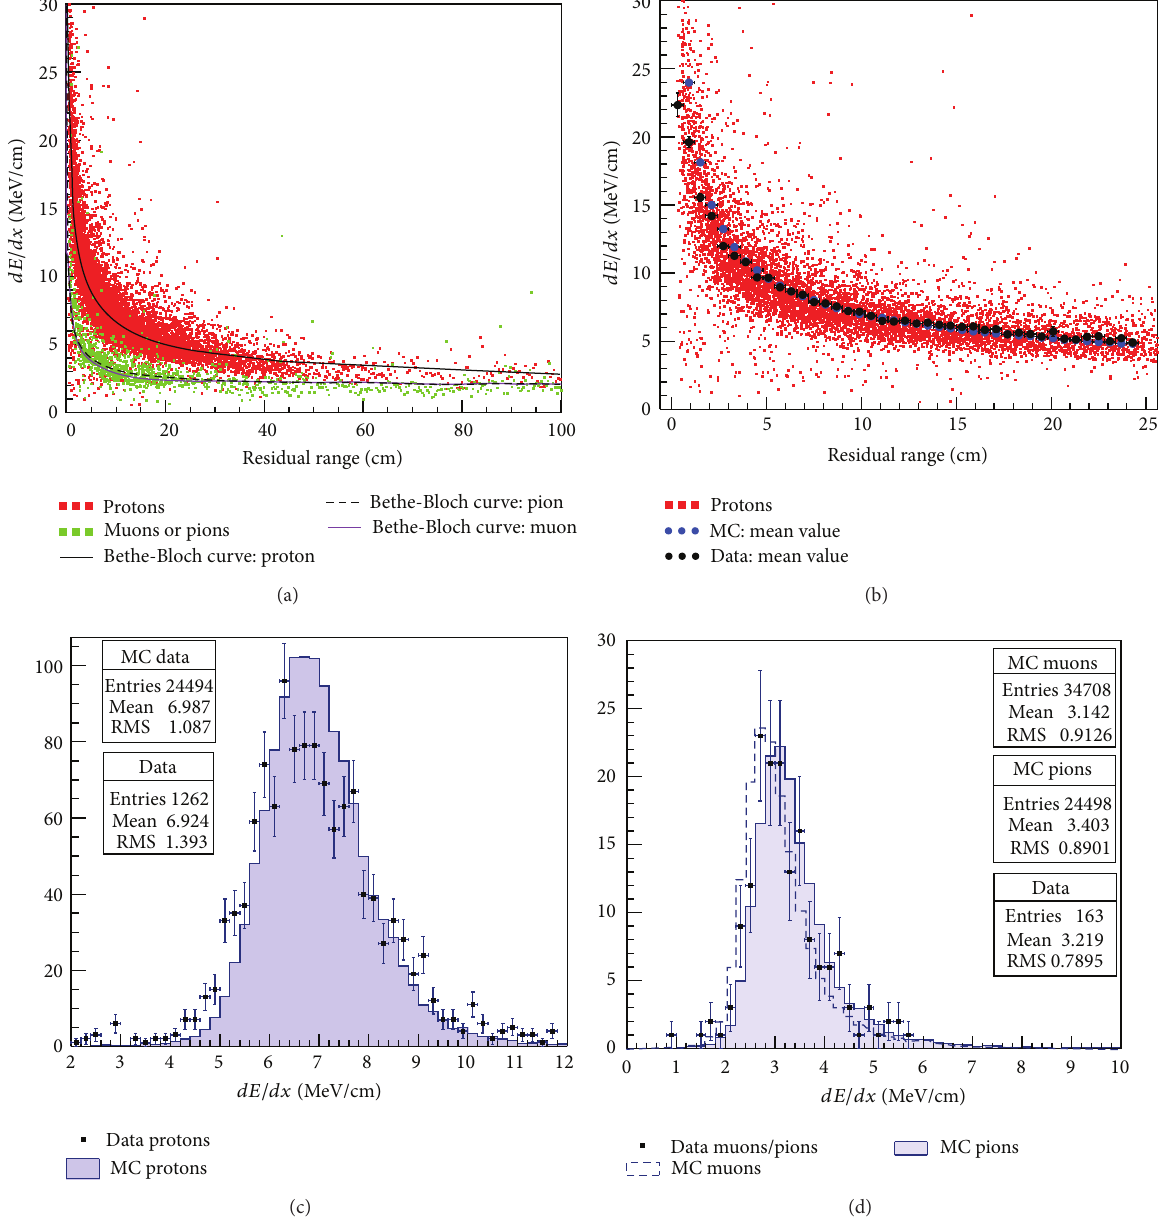
Figure 13: (a) The selected sample of data tracks identified as proton or 𝜇 / 𝜋 tracks; (b) mean value of 𝑑𝐸/𝑑𝑥 distributions in 6mm bins of residual range: black-data tracks identified as protons; blue-simulated proton tracks; points in the background-data tracks identified as protons; (c) 𝑑𝐸/𝑑𝑥 in 8–12cm residual range for tracks identified as protons, compared to simulated proton tracks; (d) 𝑑𝐸/𝑑𝑥 in 8–12 cm residual range for tracks identified as 𝜇 / 𝜋 , compared to simulated muon and pion